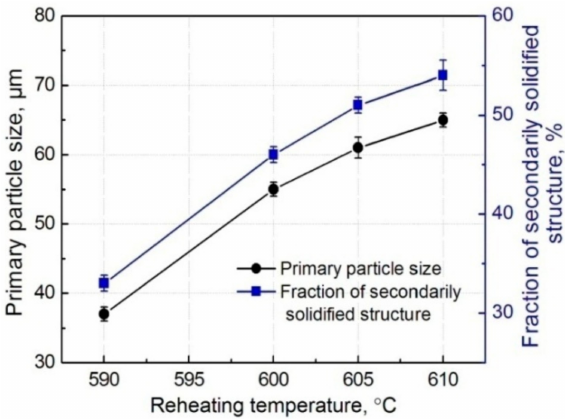
Figure 2. Variations of primary particle size and secondarily solidified structure amount vs reheating